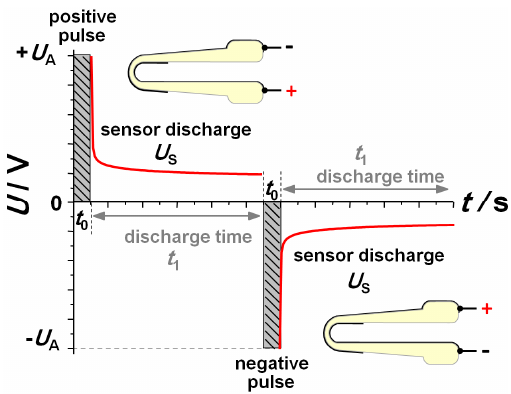
Figure 3. Scheme of the pulsed polarization technique (polarization parameter: U t = 1.0 s, t = 10 s) and the corresponding polarization sign of the 0 1